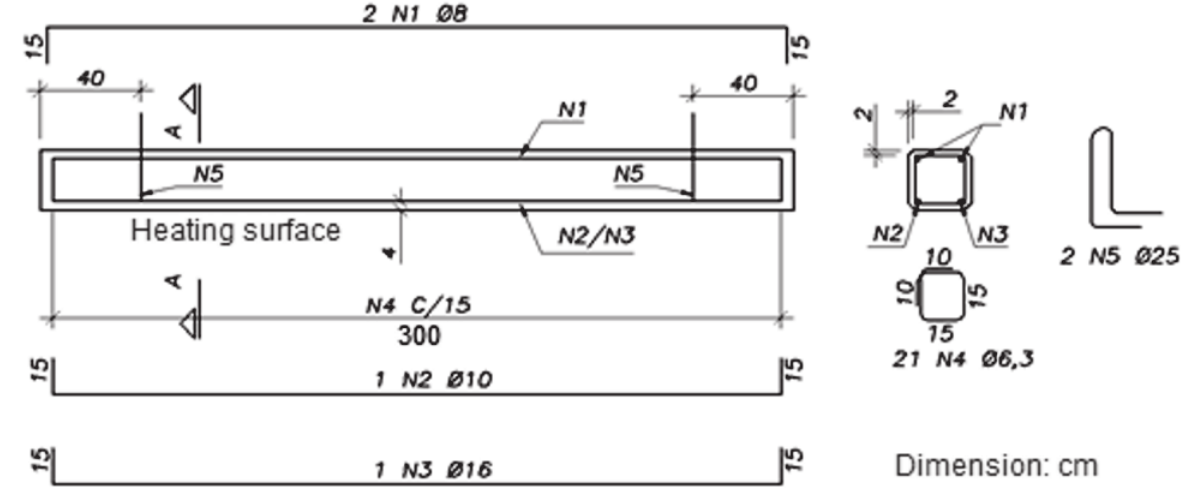
Reinforcement configuration of the